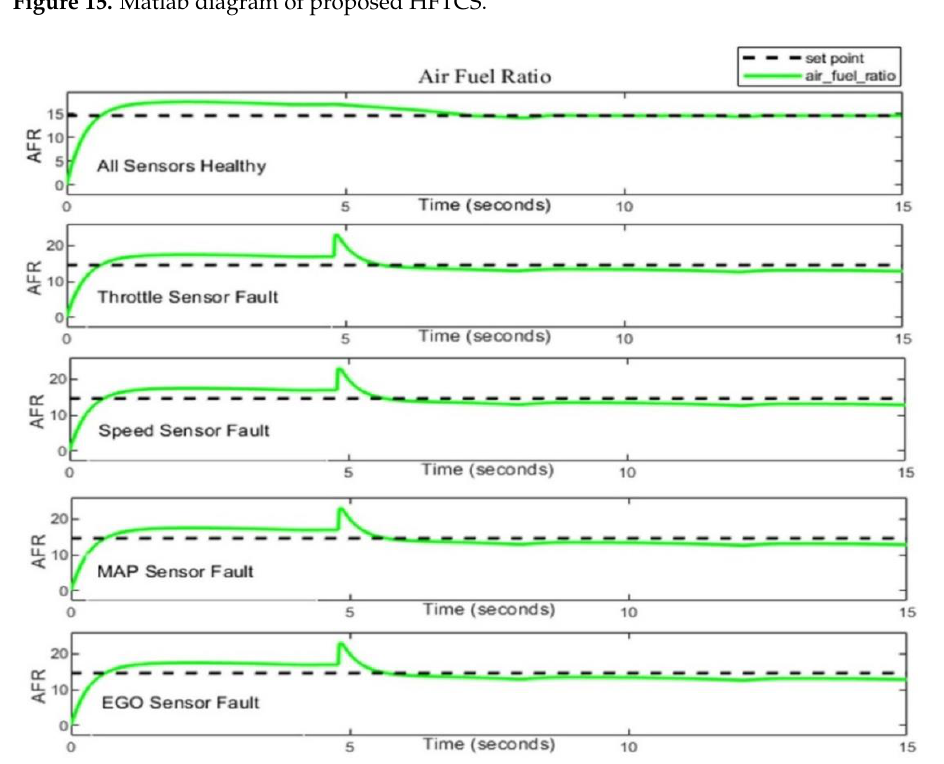
Figure 16. Overall performance of HFTCS.